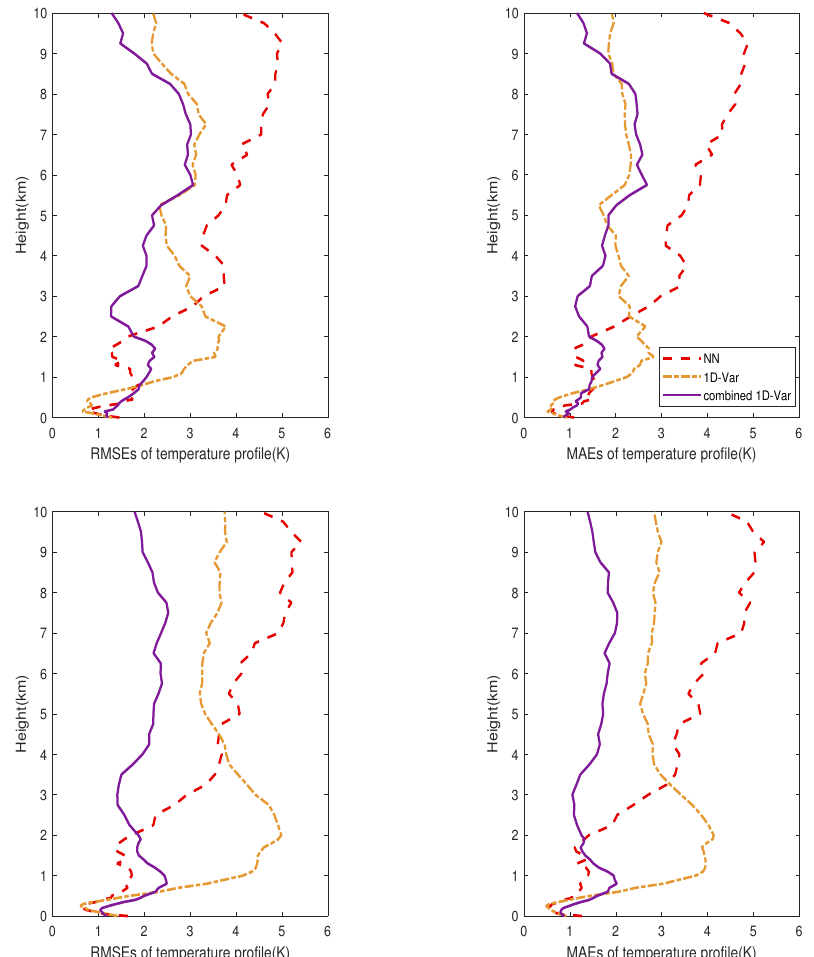
Figure 6. The RMSE ( left ) and MAE ( right ) profiles for temperature from the NN (red dashed), 1D-Var (yellow dashed), and combined 1D-Var (purple solid) methods for clear skies ( top row ) and cloudy ( bottom row